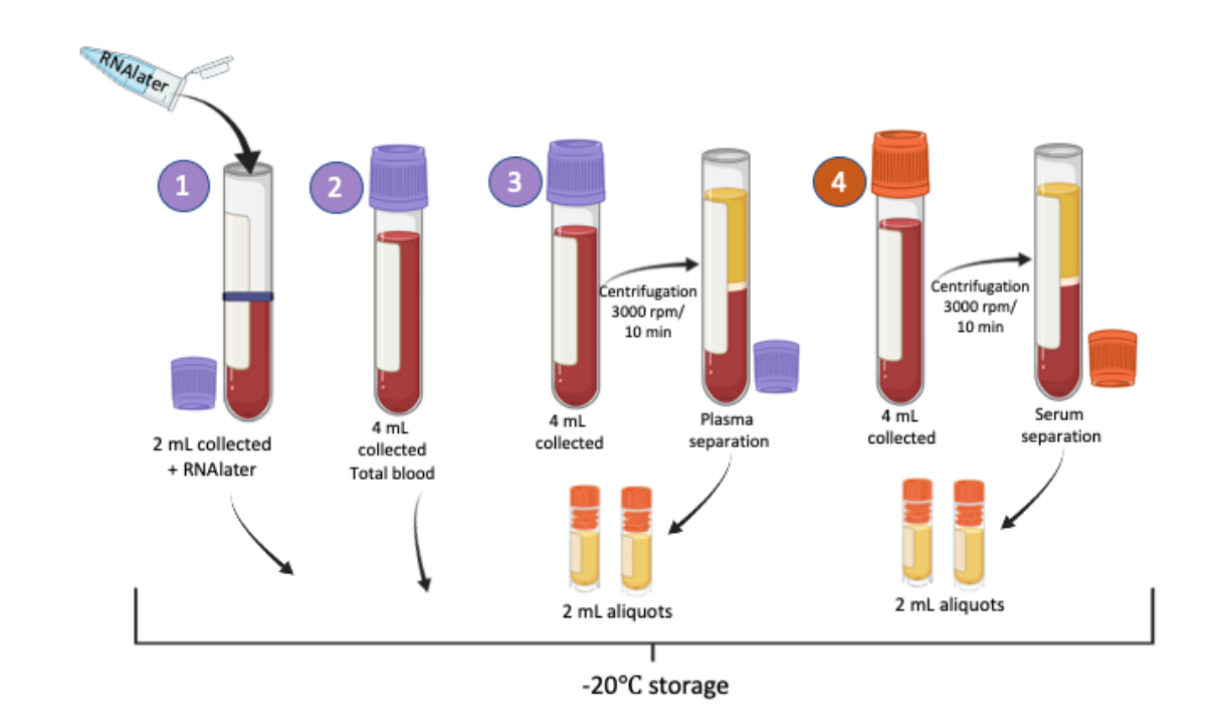
Figure 3. Blood collection and storage protocol: The blood from the peripheral vein will be collected in a total of 16 ml: 3 EDTA tubes, one with 2 ml and two with 4 ml and 1 dry tube with separating gel. To the first EDTA tube, where 2 ml of blood was collected, 2 ml of RNAlater will be added for later storage. The second EDTA tube will be stored with total blood. The third EDTA tube will be centrifuged for plasma separation, along with the dry tube, for serum separation. Serum and plasma will be divided into 2 ml aliquots and frozen at -20ºC, together with the tube where RNAlater was added, and the EDTA tube containing whole